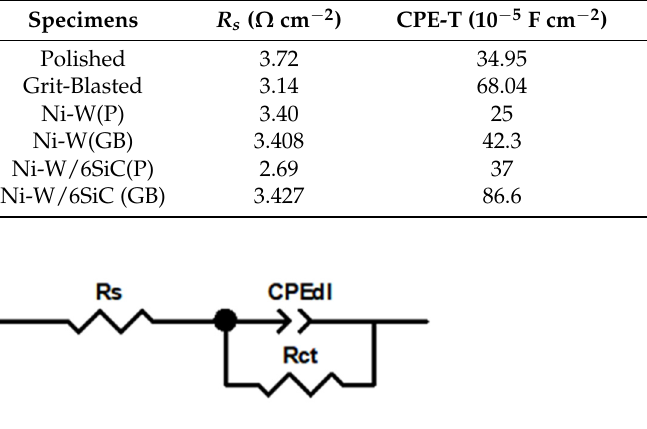
Figure 18. Equivalent circuit for the Nyquist plots analysis. Table 6. The equivalent circuit parameters and fitting results of the impedance spectra of the Ni-W and Ni-W/SiC coatings pretreated by two different processes.